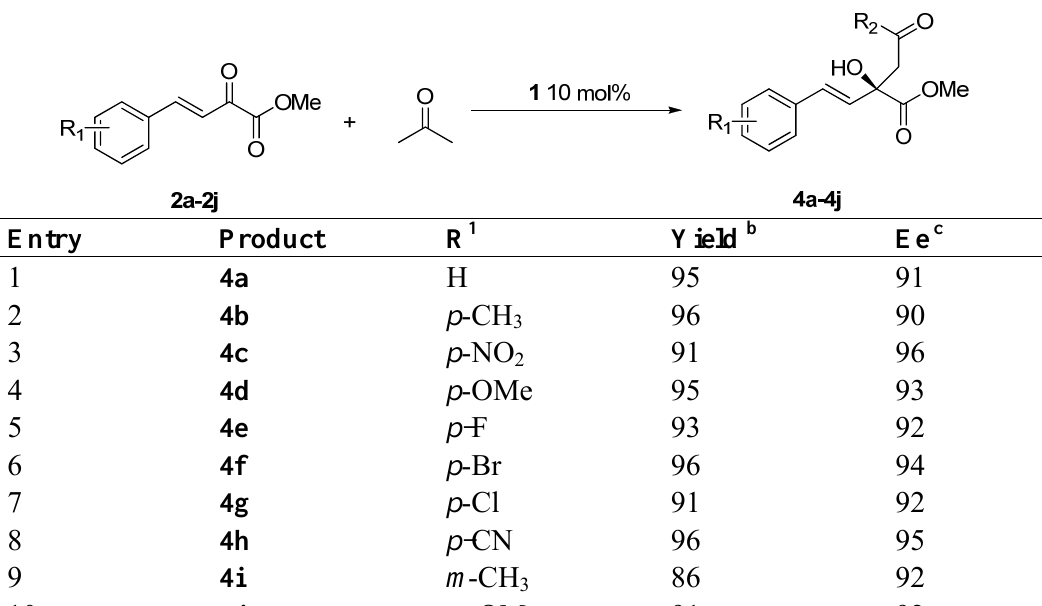
Table 3. The reactions between α,β -unsaturated ketoesters and ketone. a